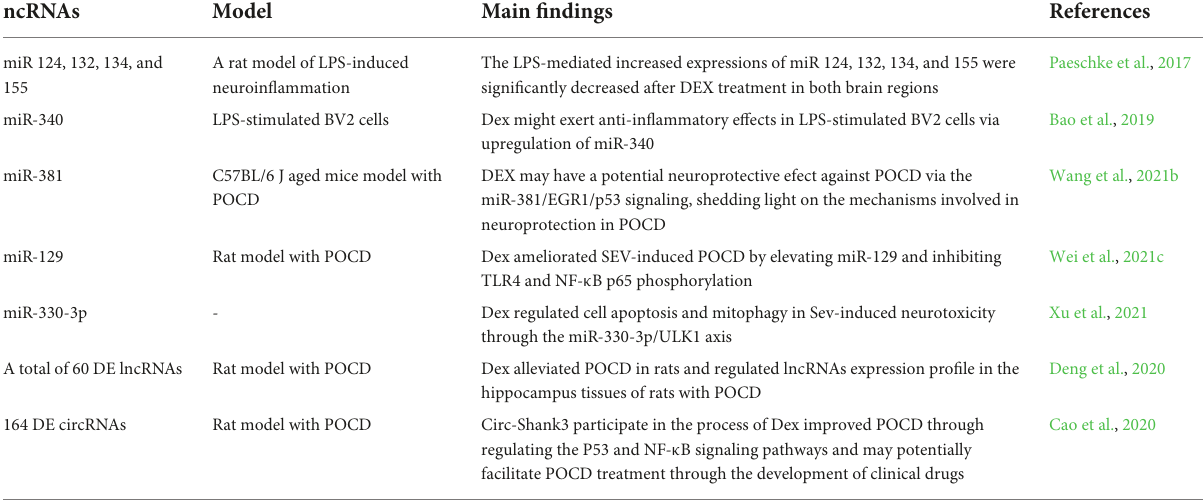
TABLE 3 Summary of ncRNAs associated with dexmedetomidine in postoperative cognitive